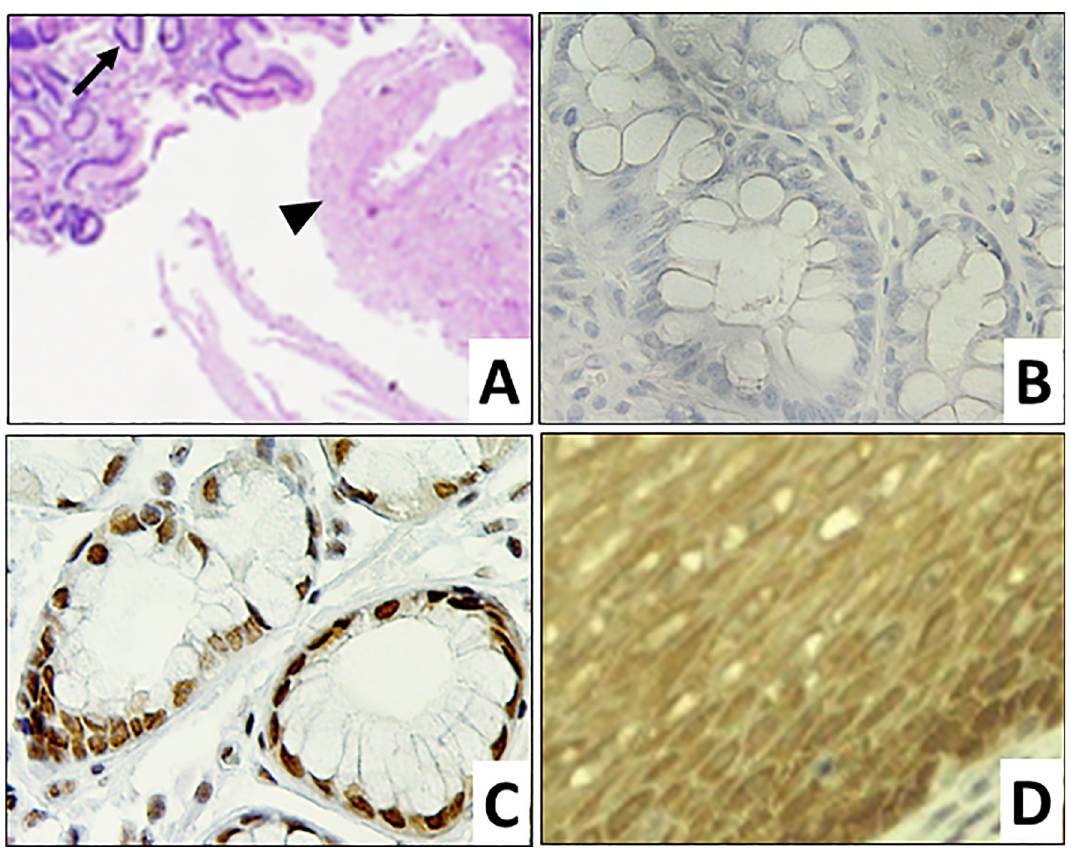
Fig 1. Maspin expression in normal GEJ tissues. Representative microscopic images of normal GEJ tissues. A. H&E of squamous ( ► ) and gastric glandular ( ! ) components (100x) of normal GEJ. B. Negative control of maspin IHC of gastric glandular epithelium (400x). C. Maspin IHC of gastric glandular epithelium (400x). D. Maspin IHC of squamous epithelium (400x).